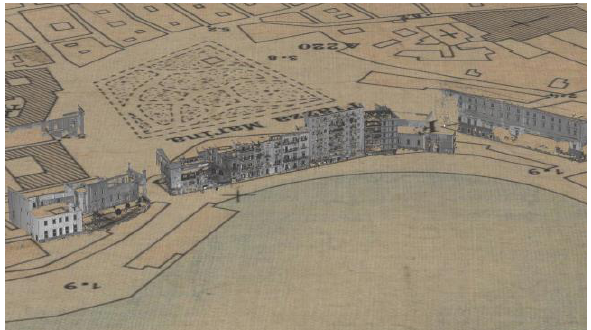
Figure 2: Laser scanning survey and the 1935’